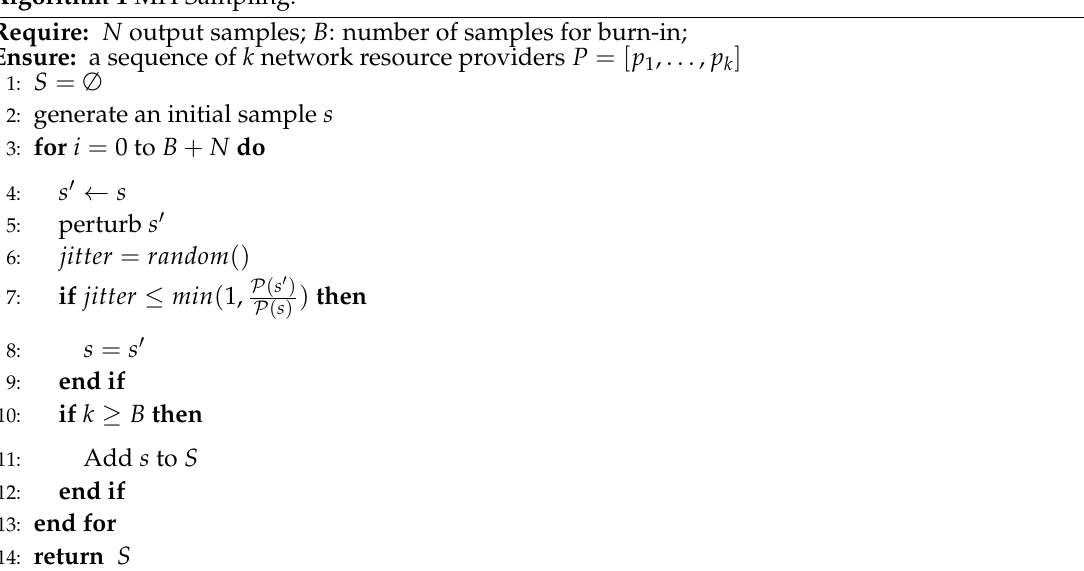
Algorithm 1 MH Sampling.